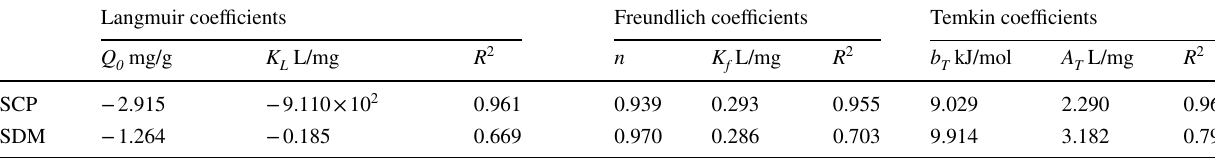
Table 5 Calculated adsorption isotherm values using linear regression analysis Langmuir coefficients